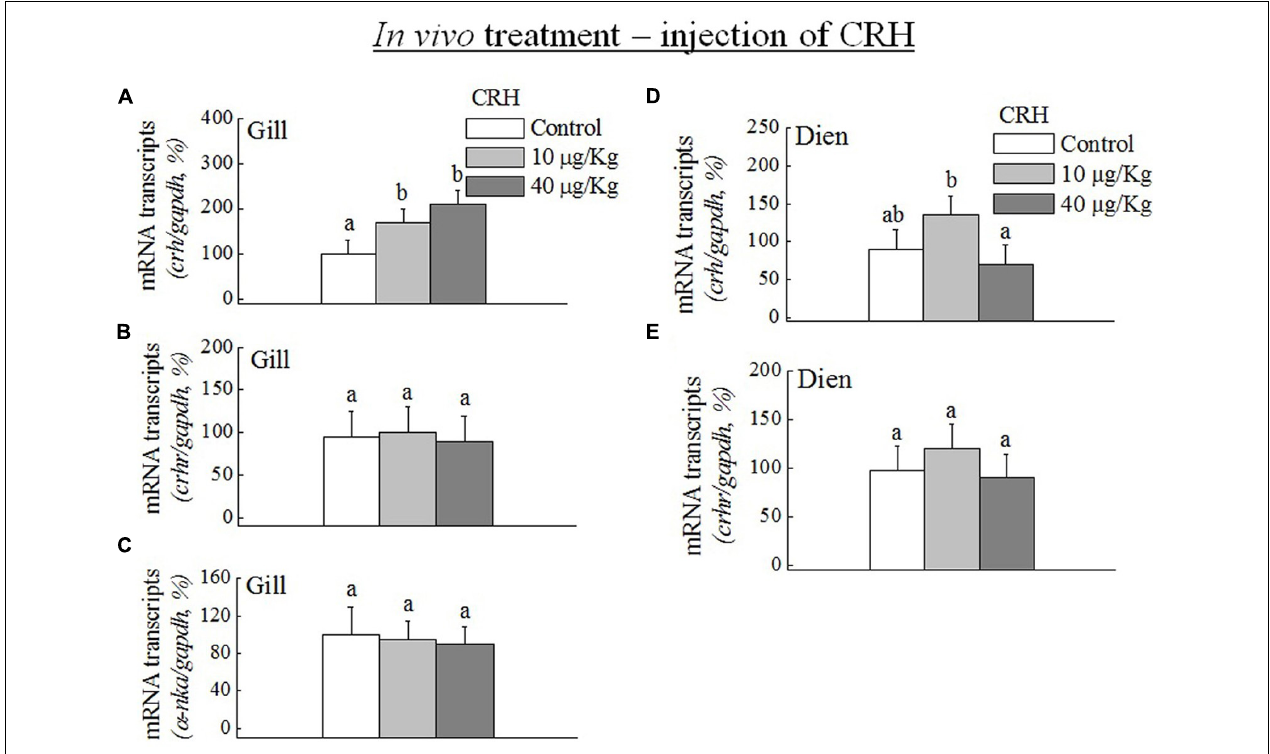
FIGURE 5 | Q-PCR analysis was performed to examine the mRNA expression of crh , crhr, and a-nka in the gill (A–C) and diencephalon (Dien) (D,E) during in vivo CRH treatment with low (10 µ g/kg) and high (40 µ g/kg) doses. Data ( n = 8 for each data) are expressed as means ± standard error of the mean. The values were analyzed by one-way ANOVA, followed by a Student–Newman–Keuls multiple test, with p < 0.05 indicating a significant difference, are denoted by “a” and